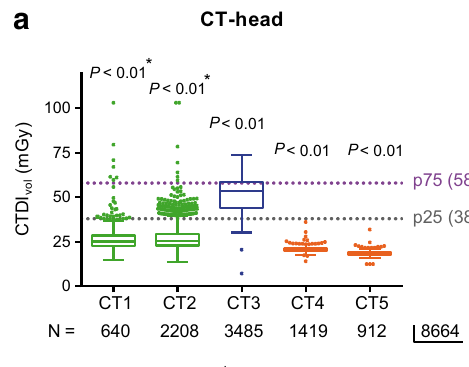
Fig. 2 Effect of using dose-tracking systems on differences in CTDI vol levelsbetweenscanners within one hospital. a Graph showing the median CTDI vol and interquartile range per month (period January 2013 – June 2013) of CT-head examinations for the two CT systems in hospital A with the national P75 DRL as benchmark. b Box plot of the CTDI vol - median value, interquartile range, total range and outliers for all CT- abdomen-pelvis examinations on the five CT systems with the national P75 and P25 DRLs as benchmark, demonstrating median CTDI vol levels